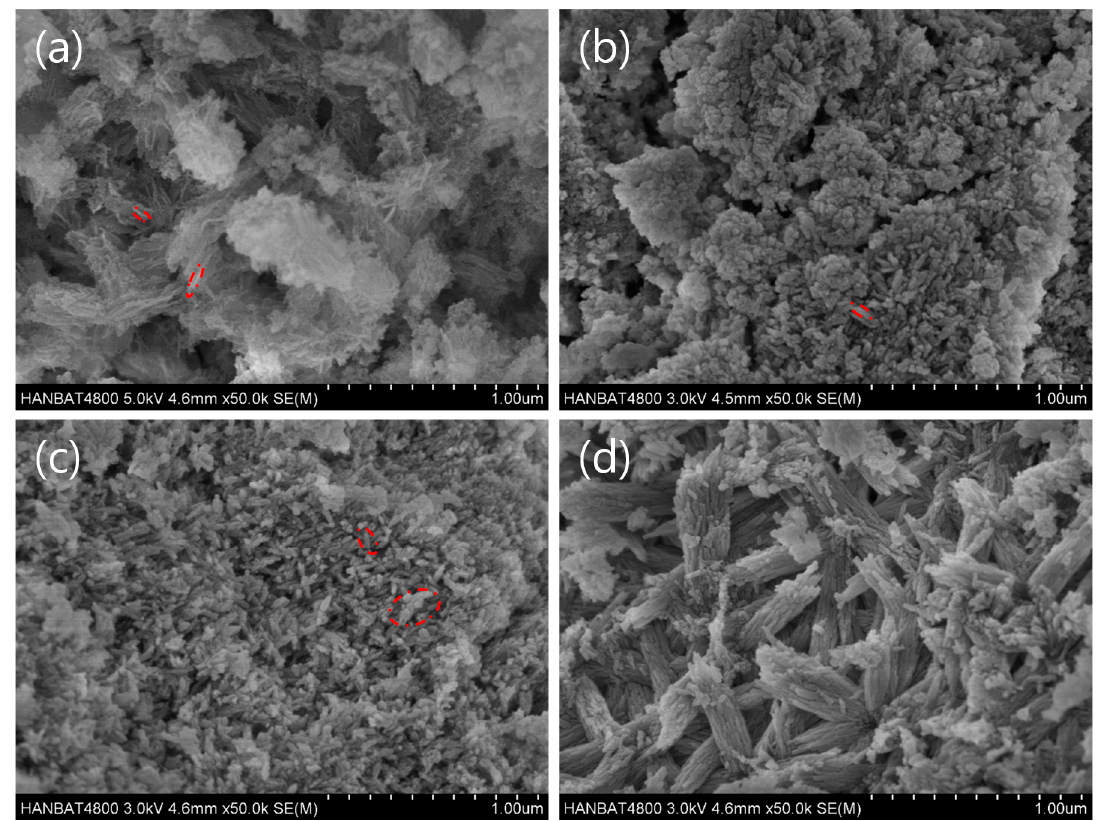
Figure 4. SEM images of hydroxyapatite crystalline obtained from ( a ) HZ-0.5, ( b ) HZ-2, ( c ) HZ-3, and ( d ) HZ-5 (red circles indicate a hydroxyapatite crystal).